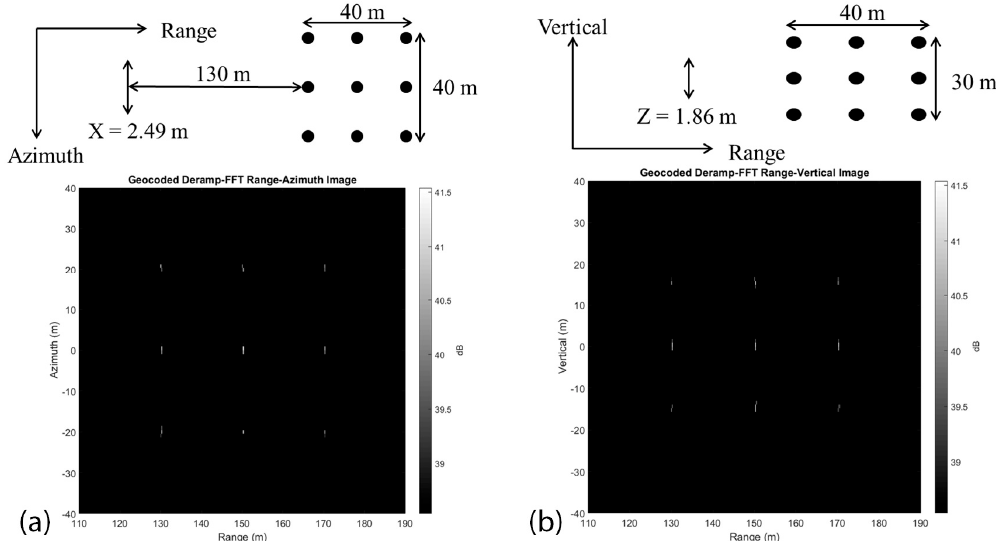
Figure 4. Simulation results of the GB-TomoSAR. A schematic geometry of point scatterers and a slice image of the focused image cone at 130 m range are shown in ( a ) range-azimuth and ( b ) range-vertical planes, respectively. Table 1. System parameters for the GB-TomoSAR simulation and outdoor experiment.